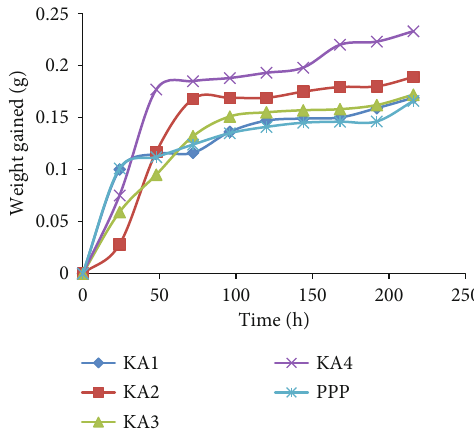
Figure 9: Water absorption tests for KOH-treated reinforced composites and the pure PP.